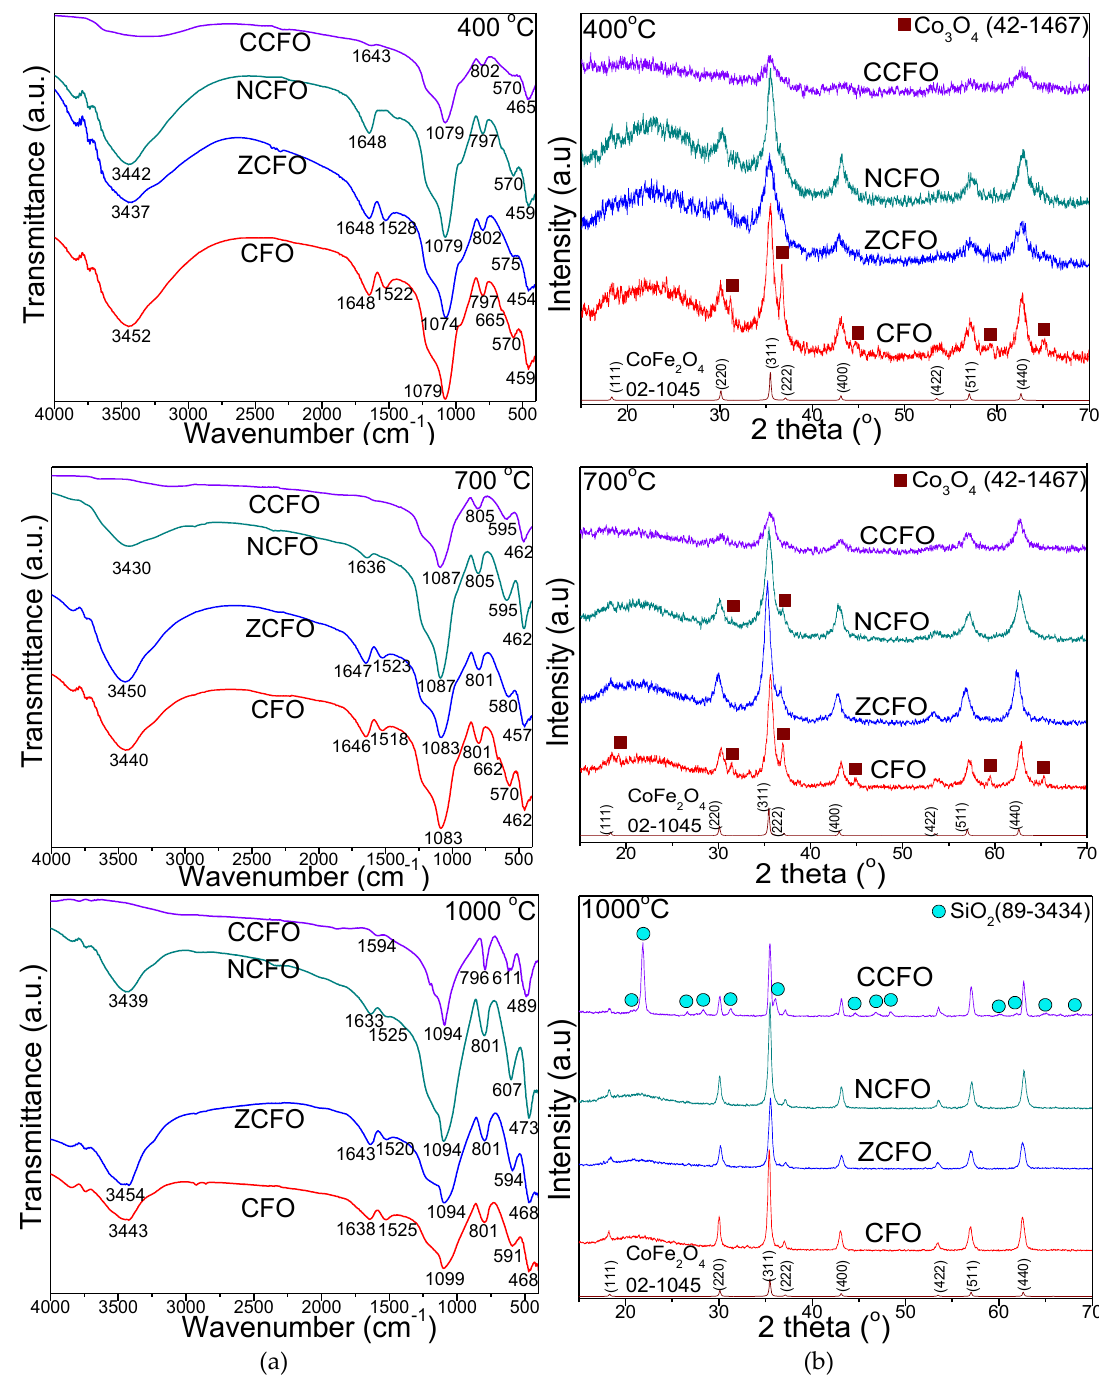
Figure 3. Fourier transform infrared spectra ( a ) and X-ray diffraction patterns ( b ) of CFO, ZCFO, NCFO, and CCFO annealed at 400, 700, and 1000 °C.